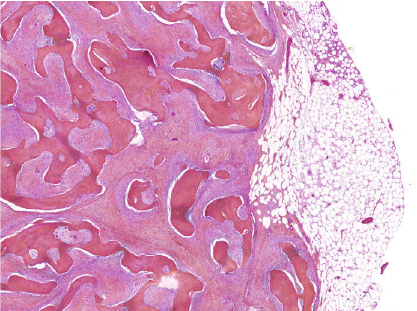
Figure 2: Histological features of the first occurrence: general view of the tumor. A central zone of osteogenesis forms an ossified core intermixed with a low-grade fibroblastic component all of which is surrounded by a mature lipogenic component that extends to the margins of the tumor.